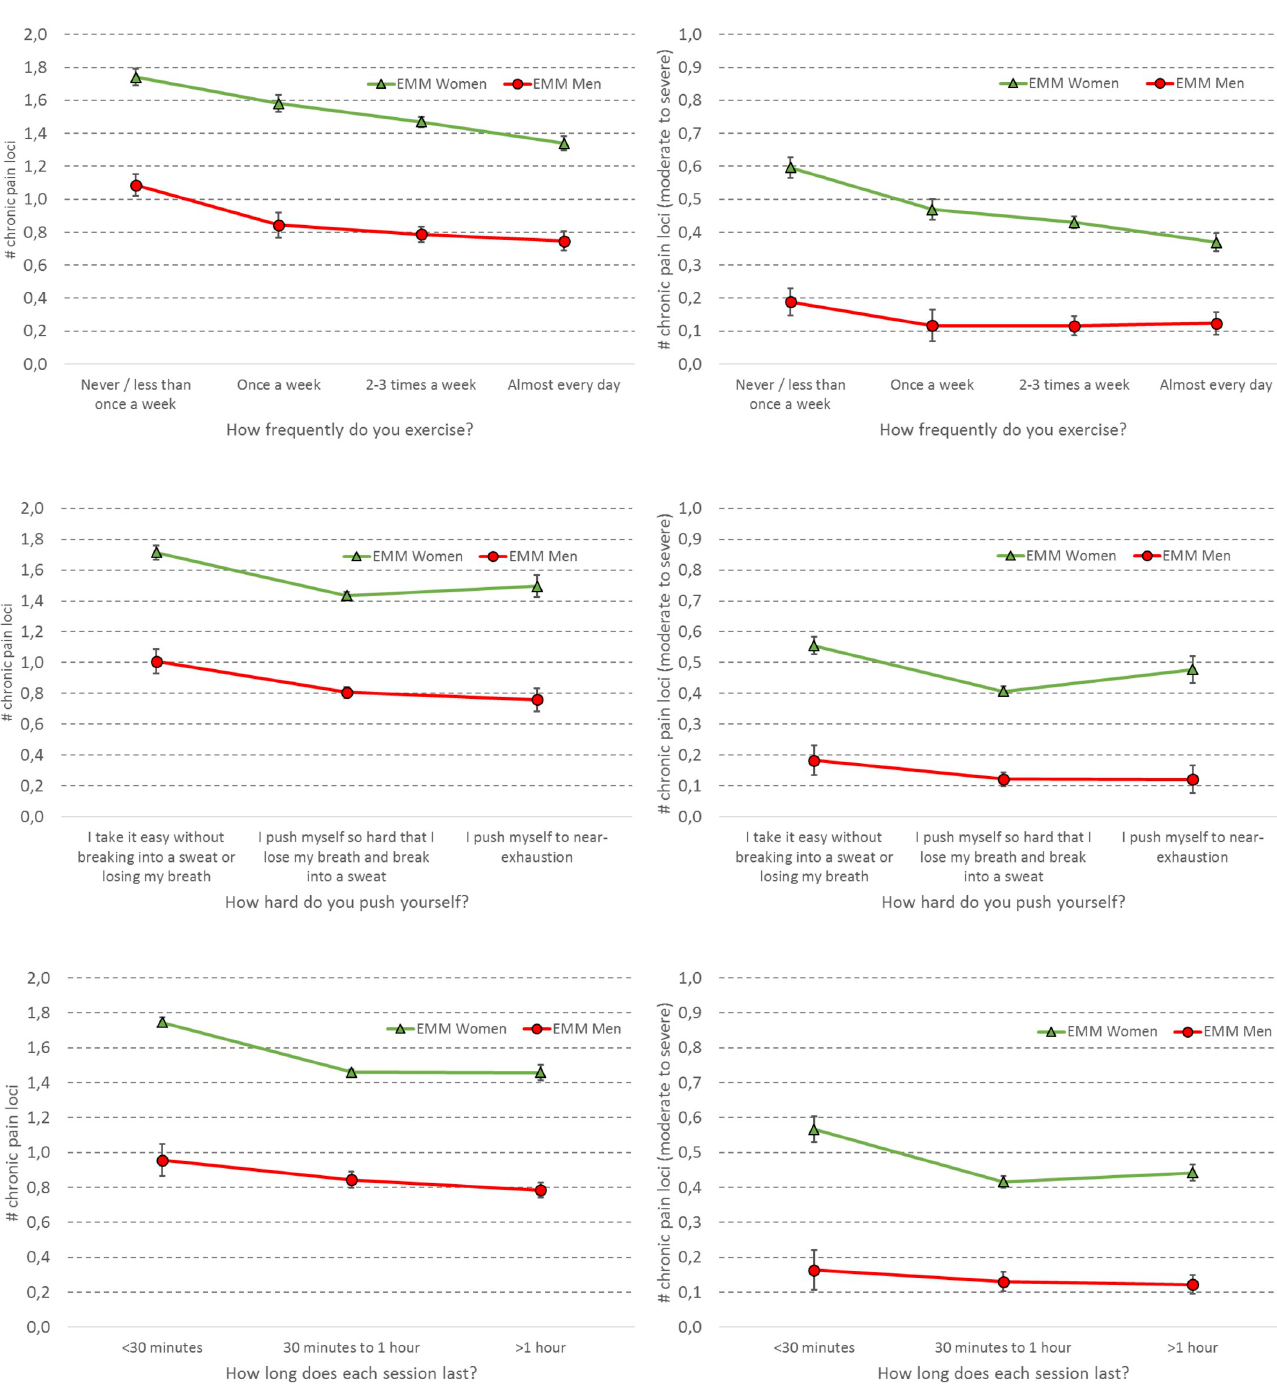
Fig 2. Association between physical exercise frequency (top), intensity (middle) and duration (bottom) and number of ICD-11 chronic pain loci (left) and number of ICD-11 moderate to severe chronic pain loci (right) for male (red) and female (green) students at Norwegian colleges and universities. Boxes represent estimated marginal means (EMM; adjusted for age), and error bars represent 95% confidence intervals.